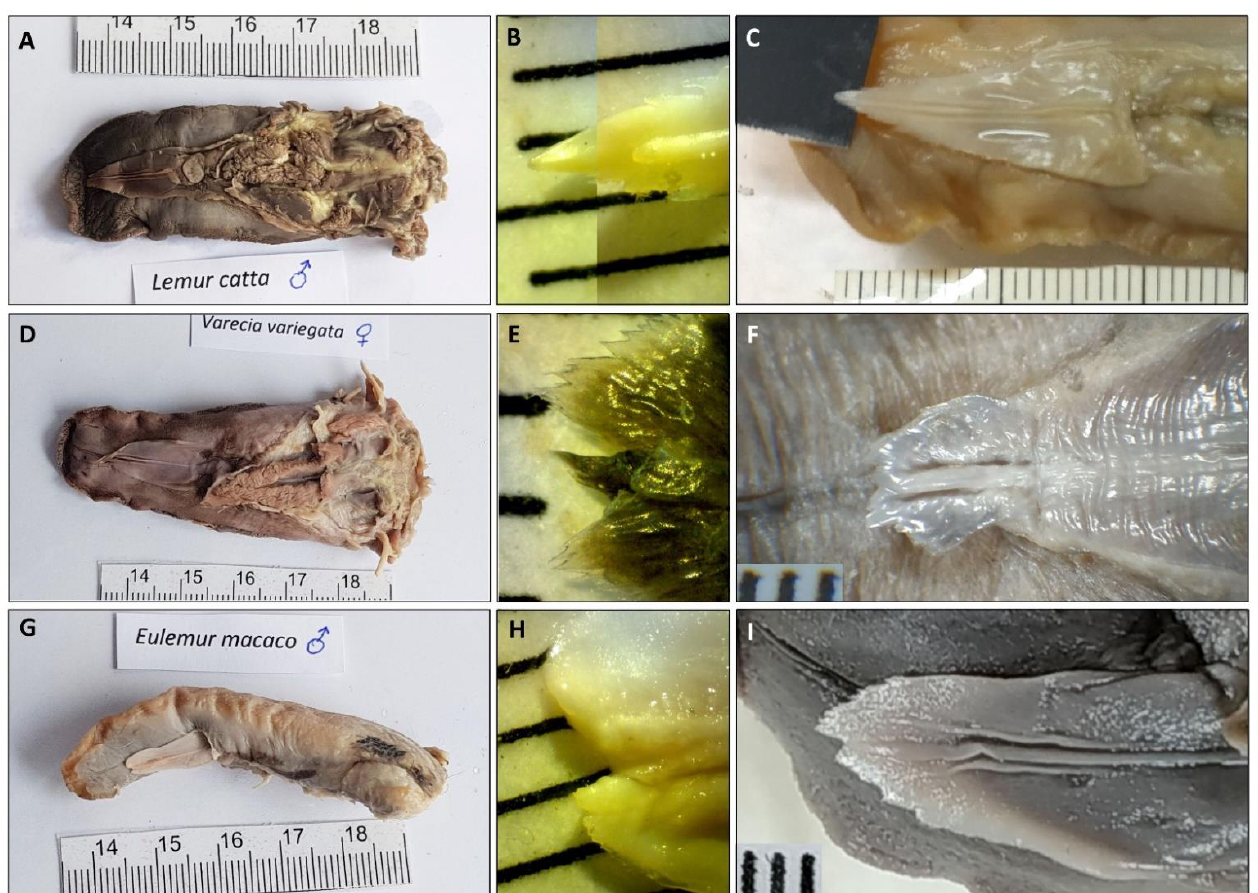
Figure 2. Ventral aspect of tongue and sublingua in Lemur catta ( A – C ), Varecia variegata ( D – F ) and Eulemur macaco ( G – I ). The sublingua tip ( B , C , E , F , H , I ) was magnified in several specimens per species. The sublingual tips in the flower-feeding species are wider and more feathered in appearance compared with Lemur catta . The minor division of the scale corresponds to one millimeter.